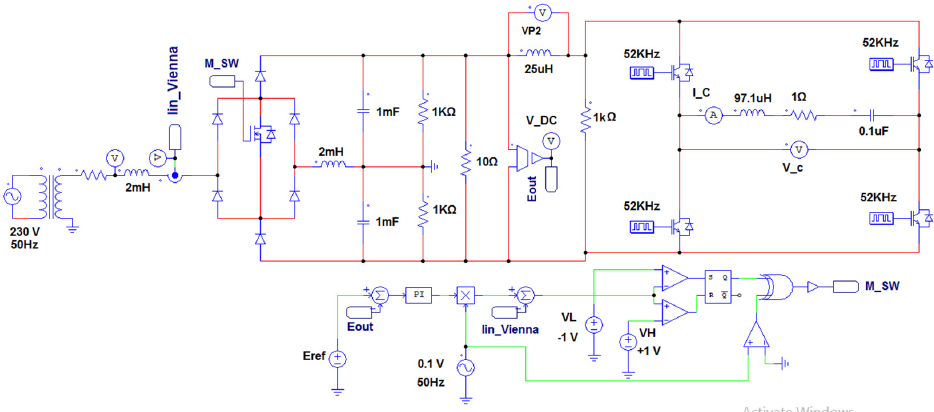
Figure 17. Simulation circuit diagram of an IH system with the MVR.